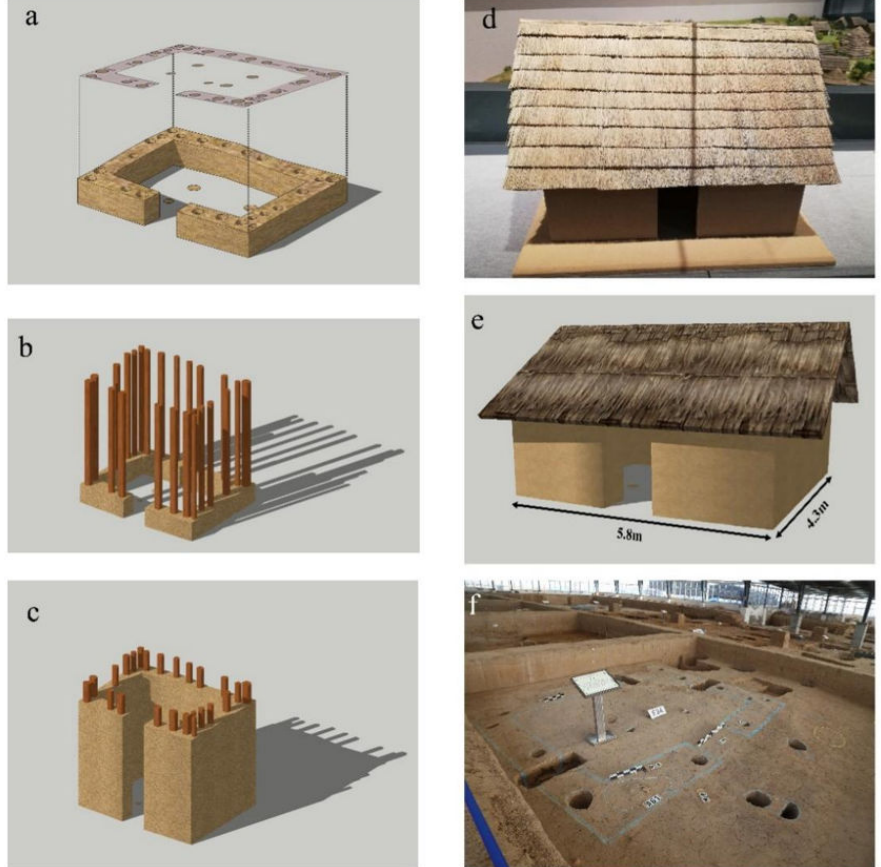
Figure 9. Example of the F34 house recovery process: ( a ) reconstruction of the house foundation based on mapped data; ( b ) insertion of wooden pillars into the foundation grooves; ( c ) plastering with grass and wood plaster to reinforce the walls; ( d ) restoration of the house at the Erlitou site; ( e ) restoration of the F34 house site; ( f ) photo of the F34 house